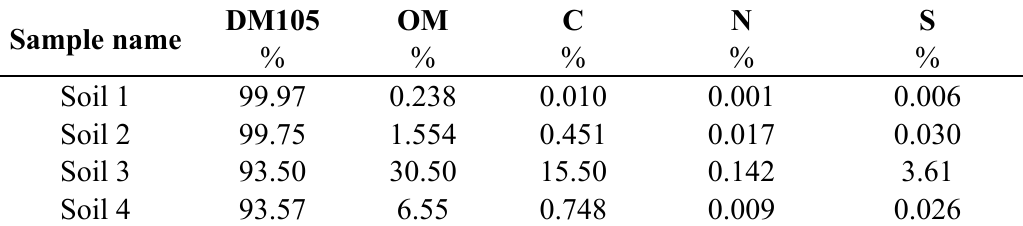
Table 1. Analysis of the air dried soil samples. The difference to 100% is the leftover which is so called “mineral